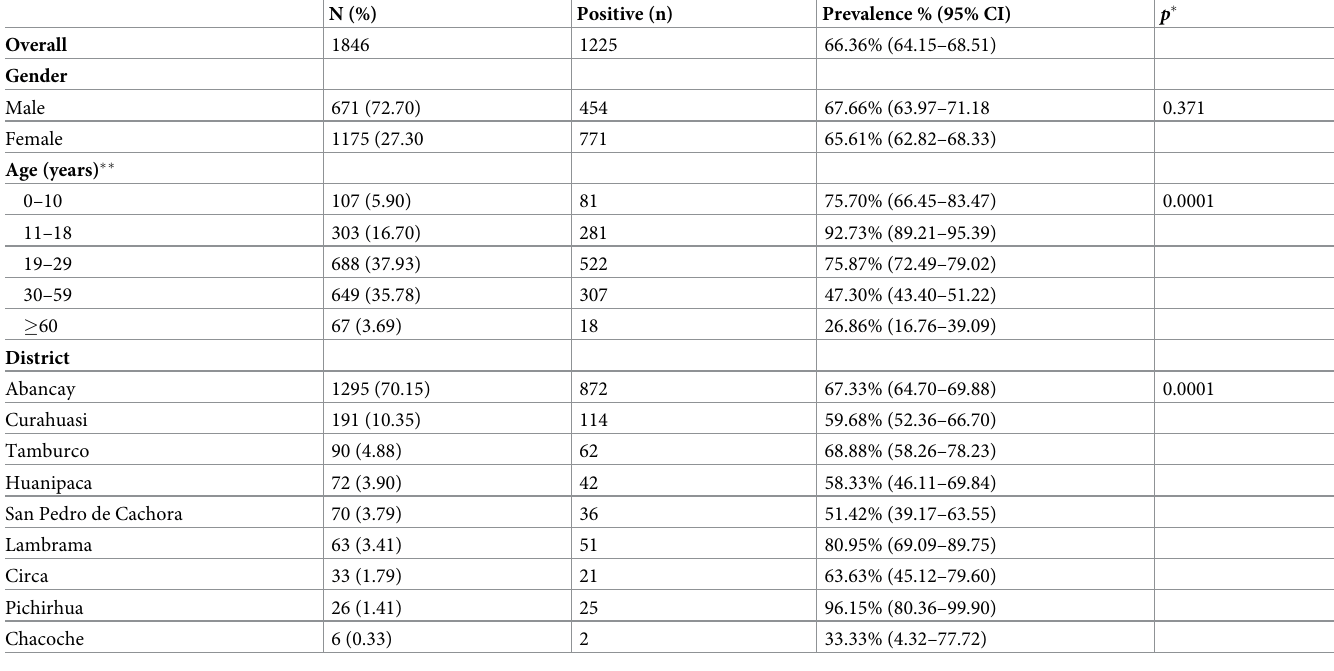
Table 2. Prevalence rate of anti-HBs � 10 mUI/ml in individuals HBsAg and total anti-HBc negative in Abancay, Peru,